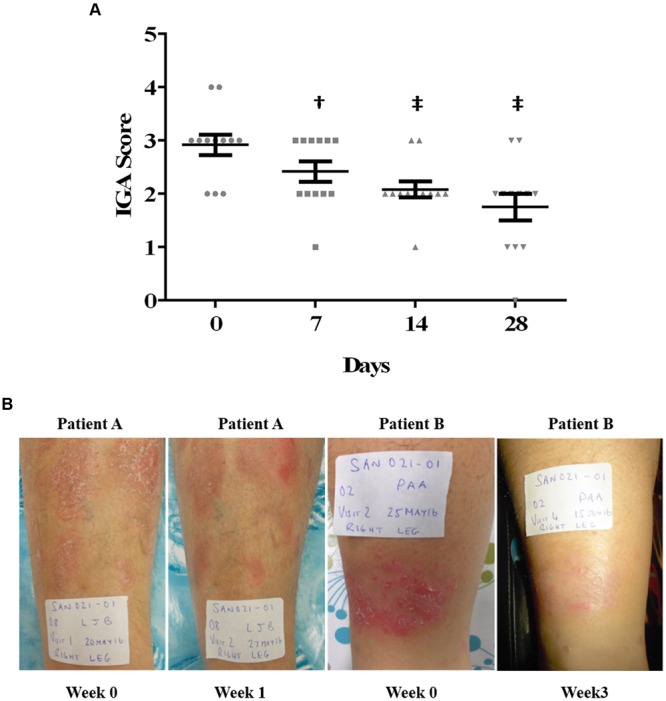
East Indian Sandalwood Oil (EISO) improves psoriasis lesion severity. (A) Response of psoriasis lesions from 11 patients to EISO treatment. Scatter plot shows each patients’ lesion IGA score at start of study (circles, Day 0) and at weekly intervals (squares, Day 7; triangles, Day 14; upside down triangles, Day 28). The mean score (black horizontal line) ±SEM is shown for each time point. †p < 0.01; ‡p < 0.001 vs. Day 0 initial scores. (B) Representative images from two patient lesions treated with EISO exhibiting a reduction in the severity of psoriatic plaques after either one (Patient A) or three (patient B) weeks of treatment.